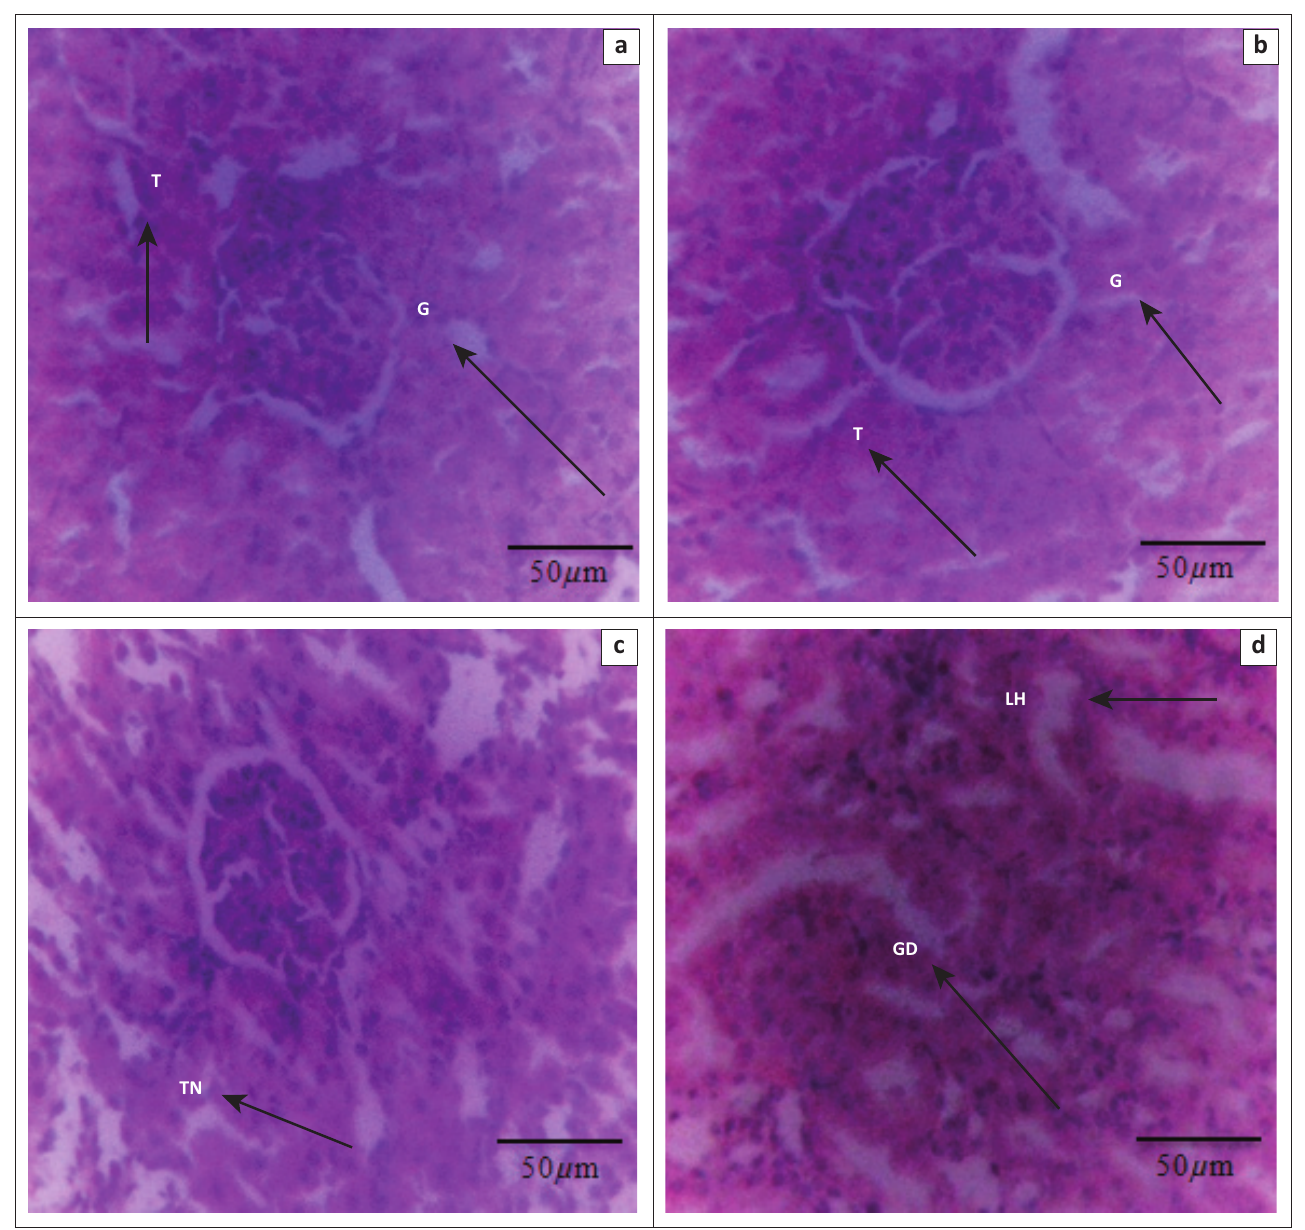
FIGURE 4: Photomicrograph of the kidney section of (a) control group rats (1 mL/kg distilled water) showing the normal glomerulus and tubules; (b) after a dose of 100 mg/kg of ethanol extract of Irvingia gabonensis root bark showing normal glomerulus and tubules; (c) 200 mg/kg of ethanol extract of Irvingia gabonensis root bark showing slight tubular necrosis; (d) 400 mg/kg of ethanol extract of Irvingia gabonensis root bark showing lymphocyte hyperplasia and a slight glomerular distortion (haematoxylin and eosin stain; magnification